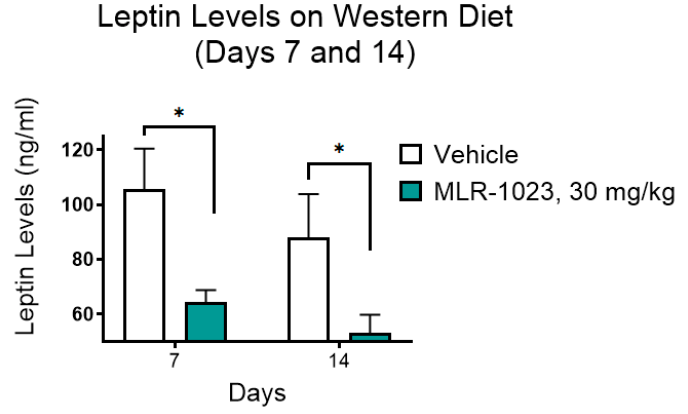
Figure 3. Effect of 30 mg/kg of MLR ‐ 1023 twice daily on blood leptin concentrations in CD1/ICR mice. The mice were dosed intraperitoneally one hour prior to being bled by a retro ‐ orbital eye bleed on days 7 and 14 after the initiation of the study. Leptin concentrations were measured on days 7 and 14. N = 6 per group. Values are mean ± SEM. * p < 0.05. 2.2. MLR ‐ 1023 Increases the Expression of Genes for Thermogenesis and Glucose Utilization in Human Adipocytes The durability of the insulin ‐ sensitizing effect of MLR ‐ 1023 is consistent with an effect on adipose tissue, which secretes numerous adipokines that increase whole ‐ body glucose utilization [30]. Human adipocytes derived from adult white adipose stem cells (HASCs) were treated for seven days with MLR ‐ 1023 at the physiologic C max of 60 μ M [13] or the vehicle. The genes for mitochondrial thermogenesis (UCP1) and fat oxidation (carnitine palmitoyltransferase 1 β (CPT1 β ) and adipose triglyceride lipase (ATGL)) were significantly upregulated (Figure 4). UCP1 is a marker for the transformation of white to beige adipocytes [31]. ATGL and CPT1 β are the enzymes that catalyze fatty acid release and transport into the mitochondria for oxidation [32,33]. Consistent with the increase in insulin sensitivity that occurs with the induction of a beige thermogenic phenotype in human adipocytes, the expression of the insulin ‐ stimulated glucose transporter, GLUT4, and the insulin sensitizer, adiponectin, increased after MLR ‐ 1023 treatment compared to the control (Figure 4).